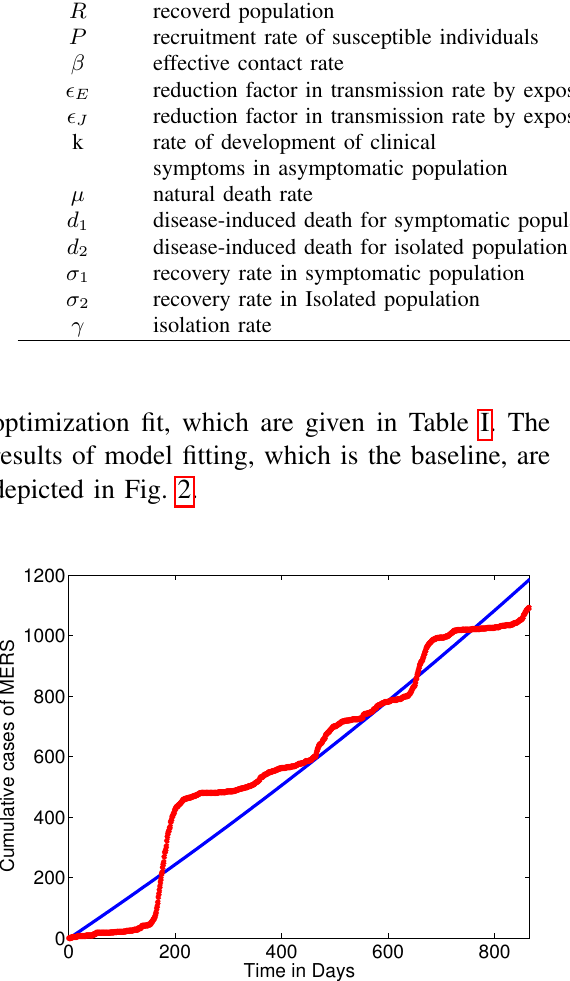
Fig. 2: MERS model parameters fit to daily re- ported cumulative new cases data - red points - obtained from Saudi Arabian Ministry of Health website during the first 865 days of the disease outbreak. The solid blue line represents the base- line model prediction. The estimated parameters are provided in Table